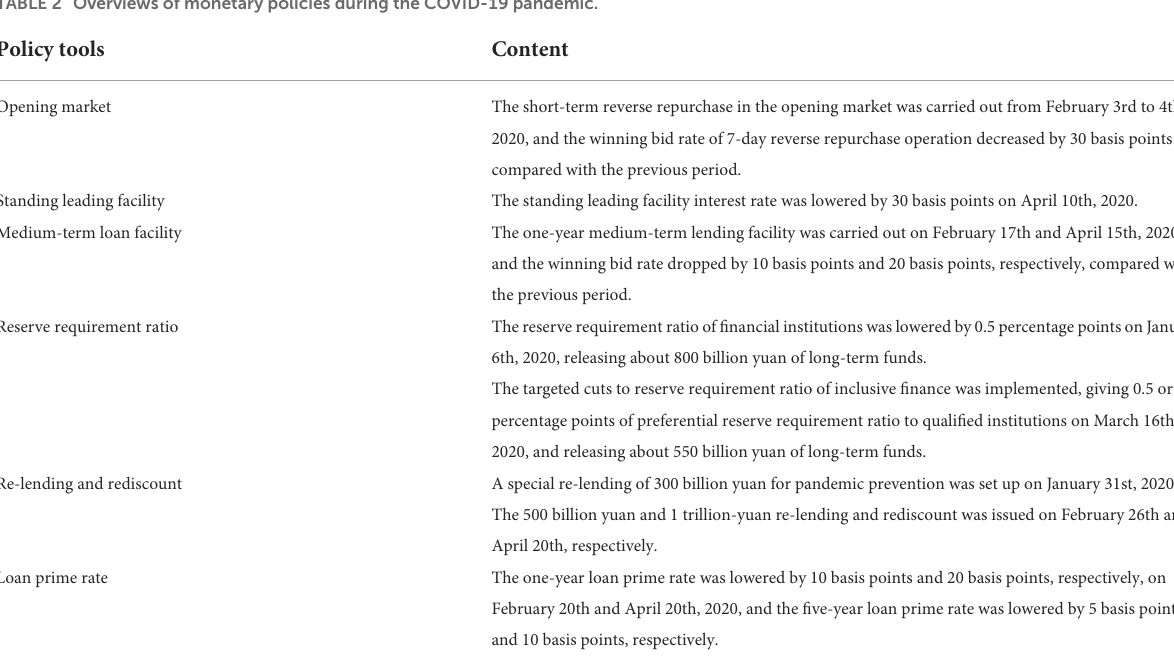
TABLE 2 Overviews of monetary policies during the COVID-19